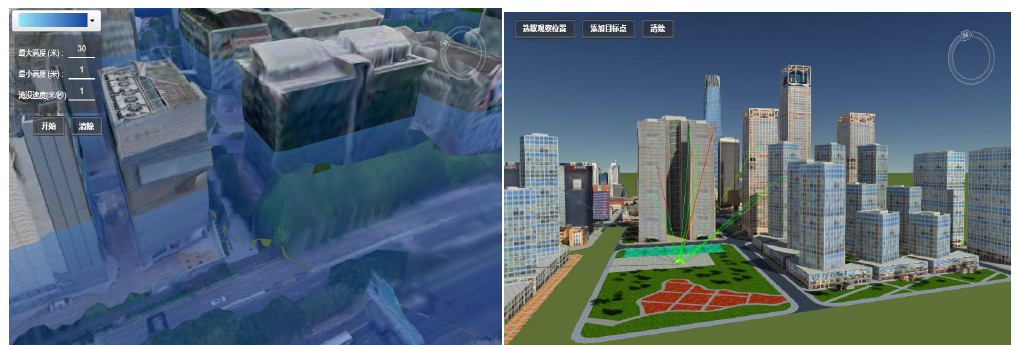
Fig.7. Inundation analysis and visibility analysis